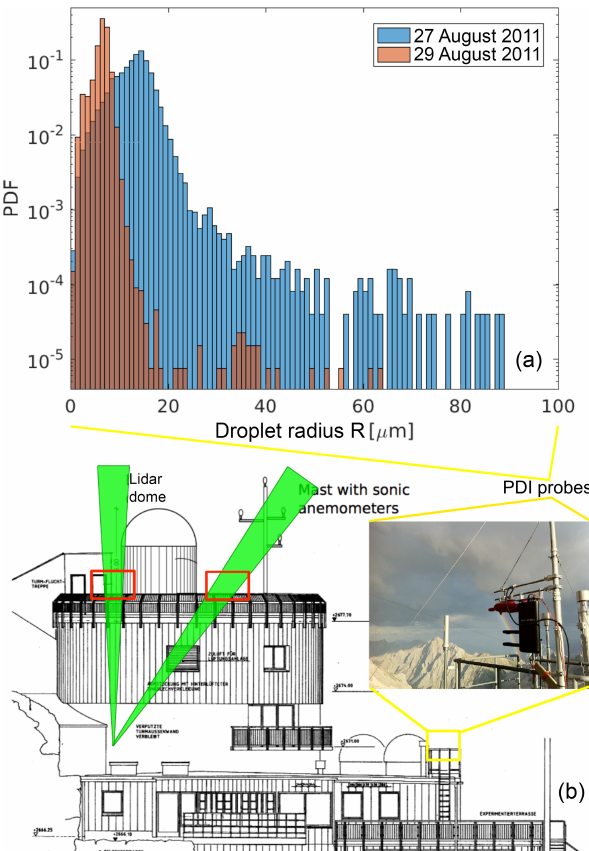
Figure 2. Droplet size distributions measured with a PDI probe (a) and the arrangement of instruments at the measurement site (b) .